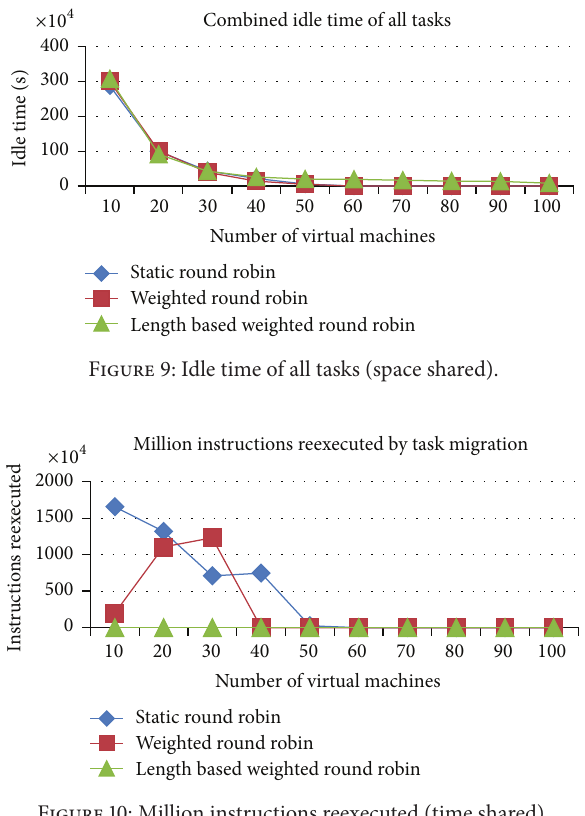
Figure 10: Million instructions reexecuted (time